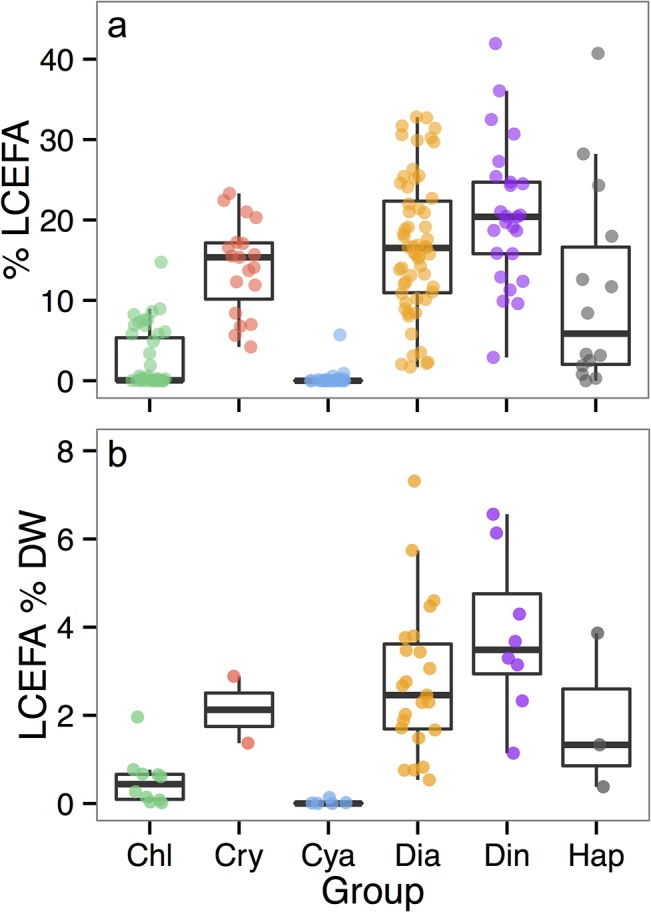
Boxplots of species averages of Σ long-chain essential fatty acids (LCEFA) in six major phytoplankton groups.(a) Shows the % FA dataset, consisting of 208 averages from 666 raw profiles. (b) Shows the FA % DW dataset, consisting of 55 averages from 105 raw profiles. Group name abbreviations follow Fig 1. The heavy line is the median, box boundaries are the 25th and 75th percentiles, and whiskers extend to the most extreme value within 1.5*IQR (interquartile range). The y-axis is set to show the extent of whiskers, thus some extreme outliers are not plotted (outliers were included in calculation of average group LCEFA).